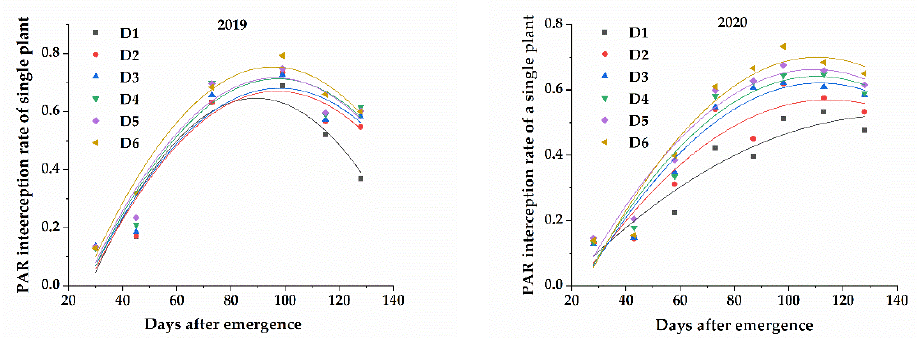
Figure 2. PAR interception rate of single plant at different planting densities in 2019 and 2020.